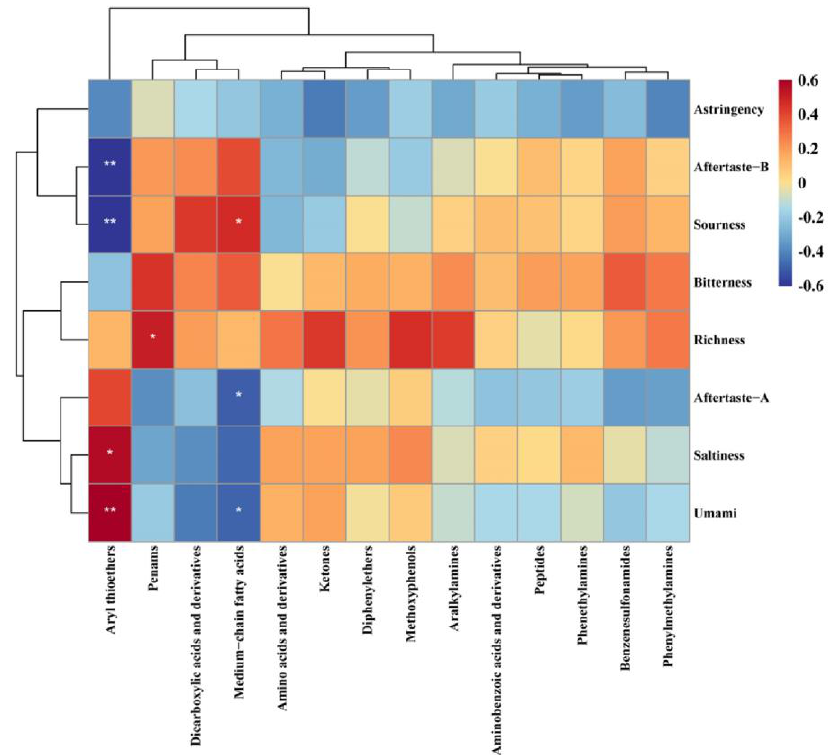
Figure 4. Correlation heatmap between the taste attributes and the content of nonvolatile taste compounds. * p < 0.05; ** p < 0.01.